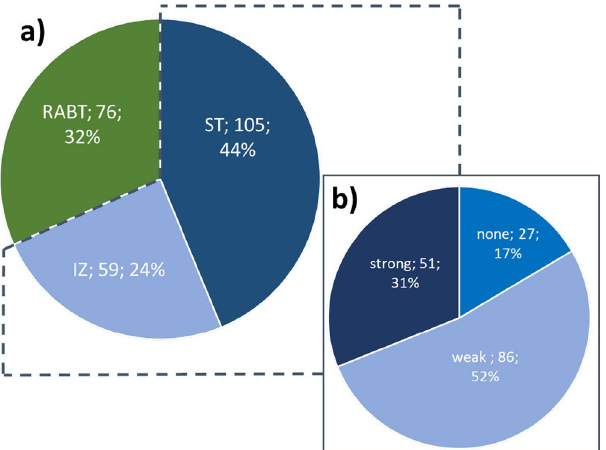
Figure 7. ( a ) Neuropathological assessment of the entire sample set, 240 biopsies. ( b ) Fluorescence qualities observed with the surgical microscope in ST and IZ biopsies (n = 164).